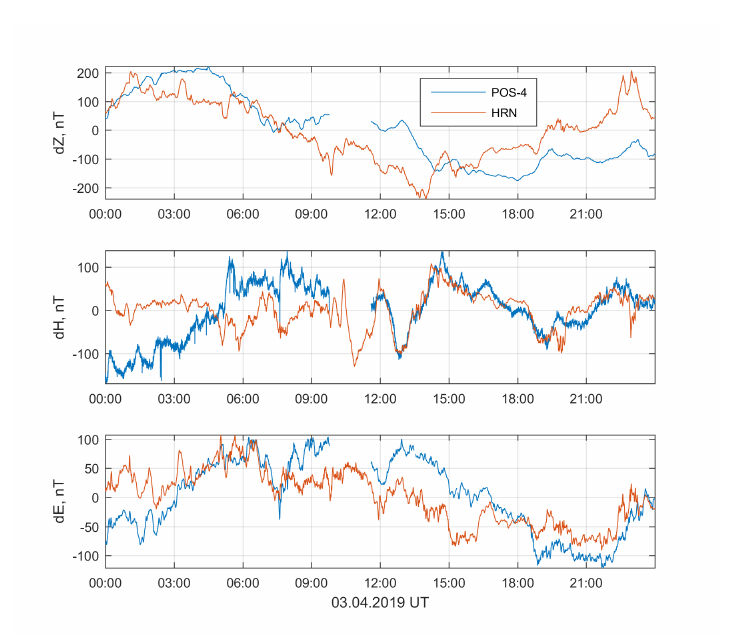
Figure 8. Comparison of the measurement results using POS-4 in the drift ice area and obtained at the HRN observatory for 03.04.2019. The average values are